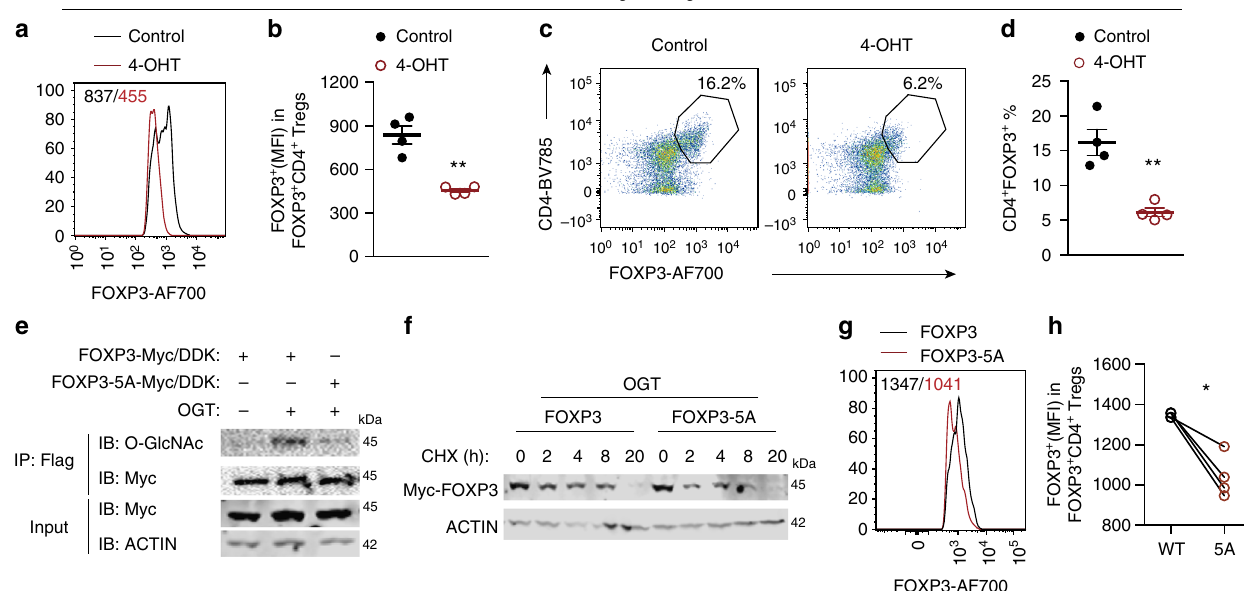
Fig. 2 O-GlcNAcylation stabilizes the FOXP3 protein in Treg cells. a – d Treg cells isolated from Ubc-CreER + Ogt fl /Y mice were treated with 4-OHT for 3 − day ex vivo, ethanol was used as the control, n = 4 each group. MFI of FOXP3 in CD4 + FOXP3 + Treg cells was analyzed in a and quanti fi ed in b . Representative fl ow cytometry of CD4 + FOXP3 + Treg cells was plotted in c and the frequencies of Treg cells were shown in d . e FOXP3 or FOXP3-5A were transfected in HEK 293 cells with or without OGT. FOXP3 O-GlcNAcylation was determined by immunoprecipitation followed by Western blotting. f FOXP3 and FOXP3- 5A stability was determined by treatment of CHX in the presence of OGT overexpression. g , h CD4 + CD25 − naïve T cells isolated from wildtype mice were infected with retroviruses expressing FOXP3 or FOXP3-5A in the presence of anti-CD3/CD28 beads ( n = 4). MFI of FOXP3 was analyzed ( g ) and quanti fi ed ( h ) in CD4 + FOXP3 + Treg cells. Data are shown as mean ± s.e.m. * p < 0.05; ** p < 0.01 by unpaired student ’ s t -test ( b , d ) and paired student ’